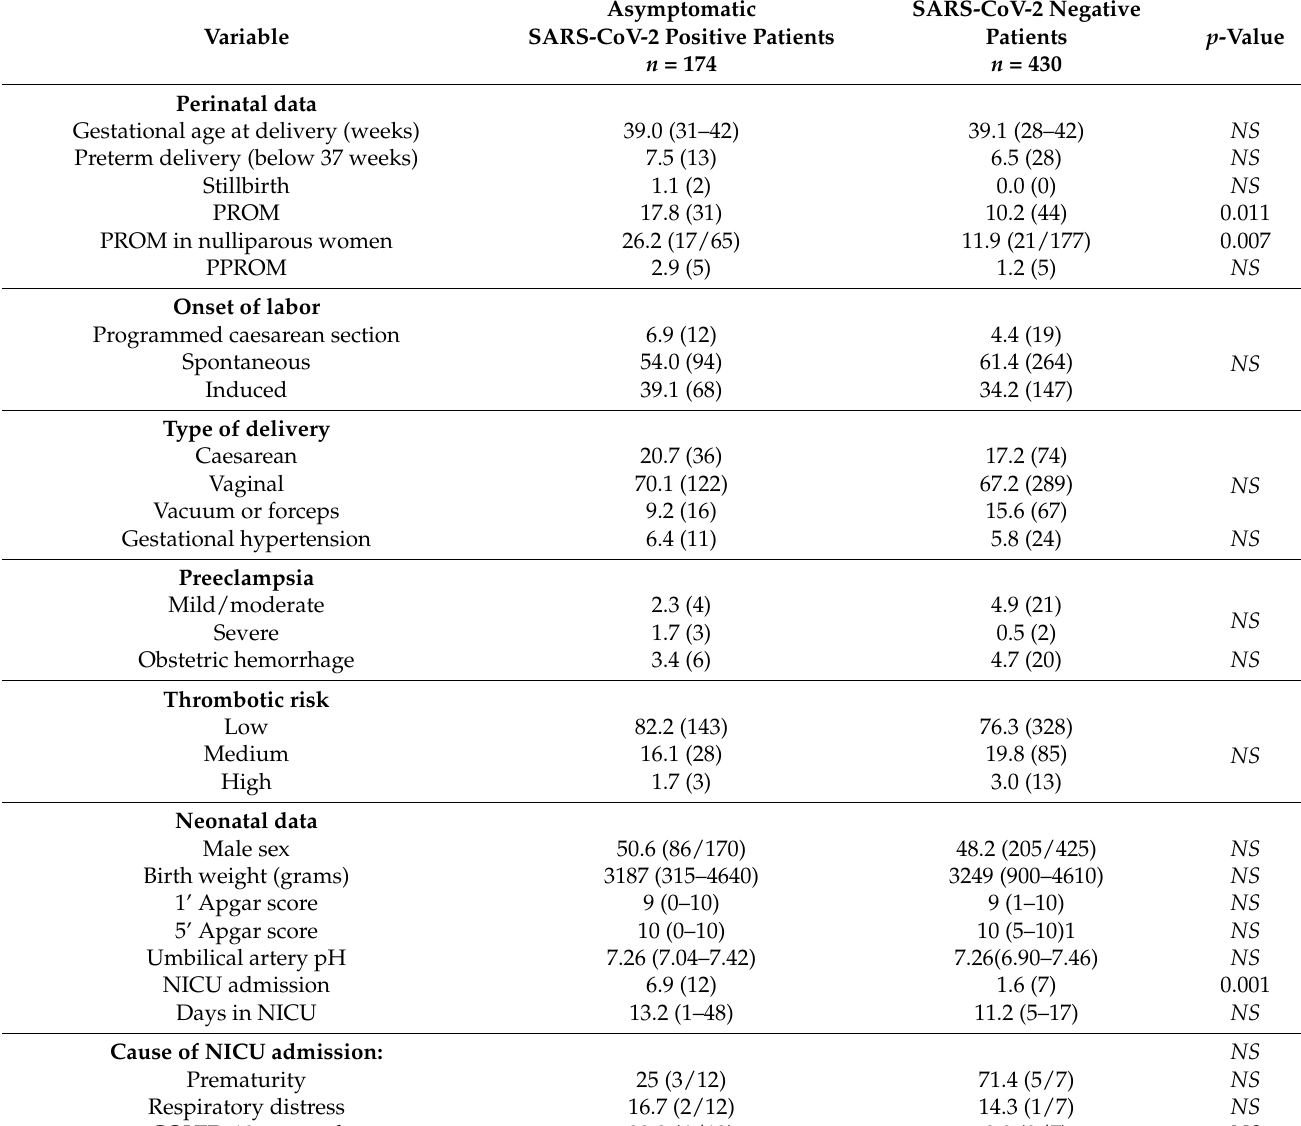
Table 3. Perinatal and neonatal data of the study population ( n =